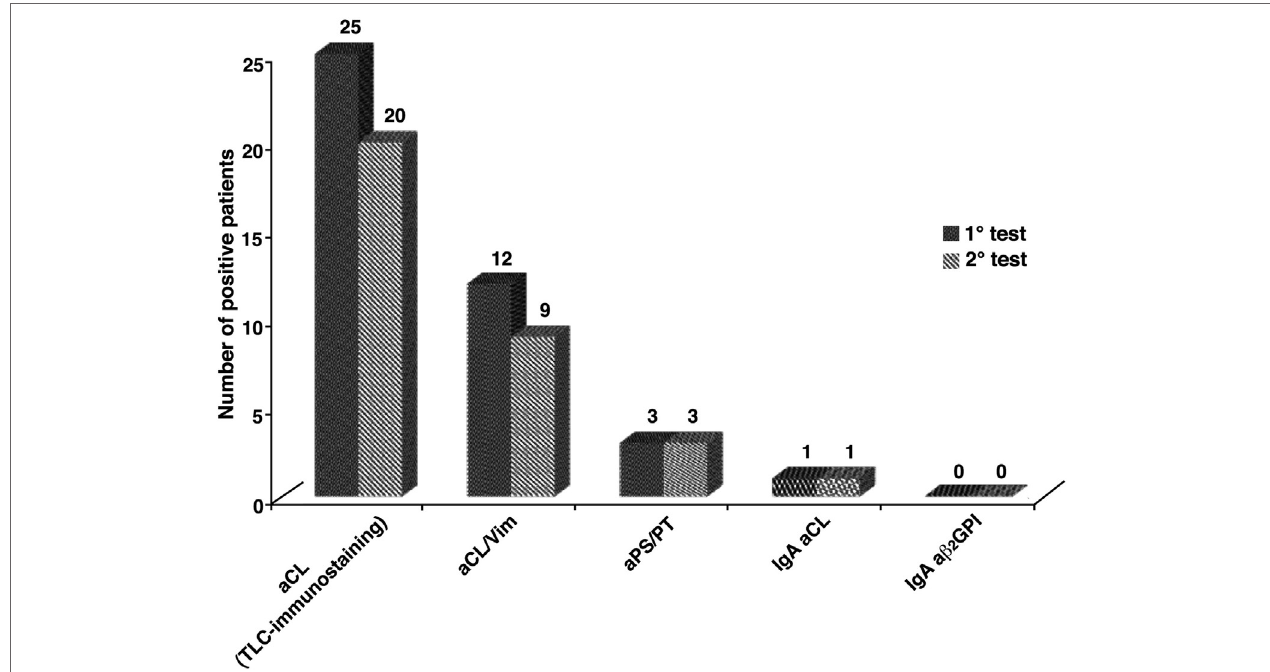
FigUre 3 | The concordance of the autoantibodies positivity, between first and second test, in obstetrical seronegative anti-phospholipid syndrome followed up where the tests were repeated on two occasions. For thin-layer chromatography (TLC)-immunostaining and anti-cardiolipin/vimentin (aCL/Vim) a “substantial agreement” was found between first and second test, revealed by Cohen’s kappa test ( K = 0.696 and K =